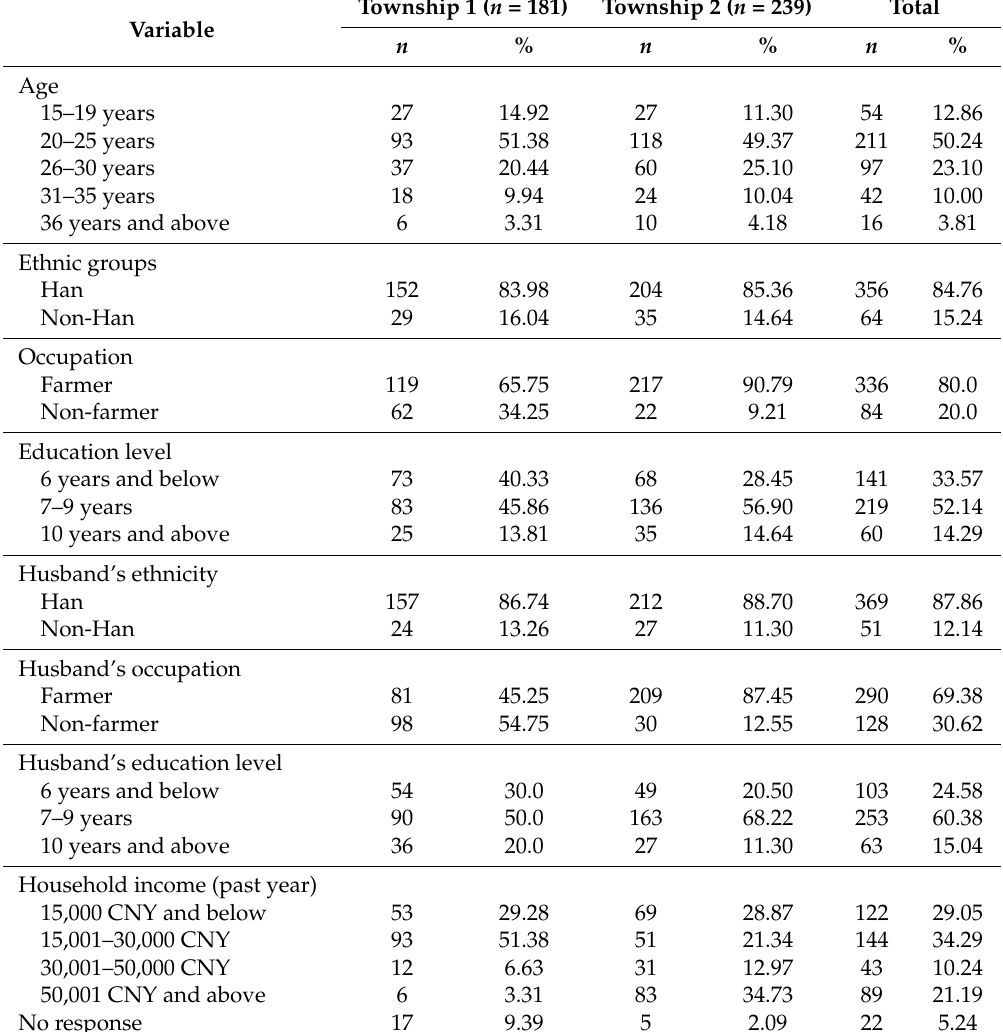
Table 1. Demographic characteristics for the study sample of rural pregnant women ( N =